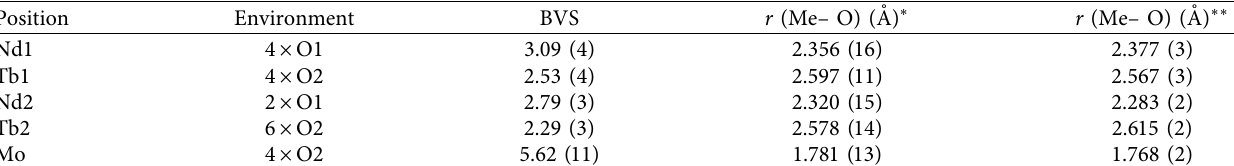
Table 5: Some interatomic distances and bond valence sums (BVS) for Nd ( ∗∗ ).